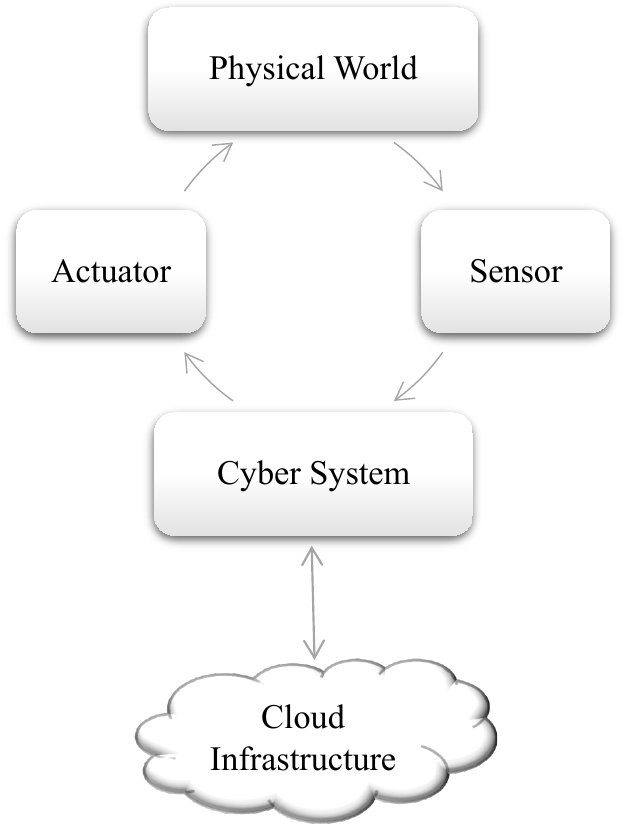
Figure 3. Cyber–physical cloud process